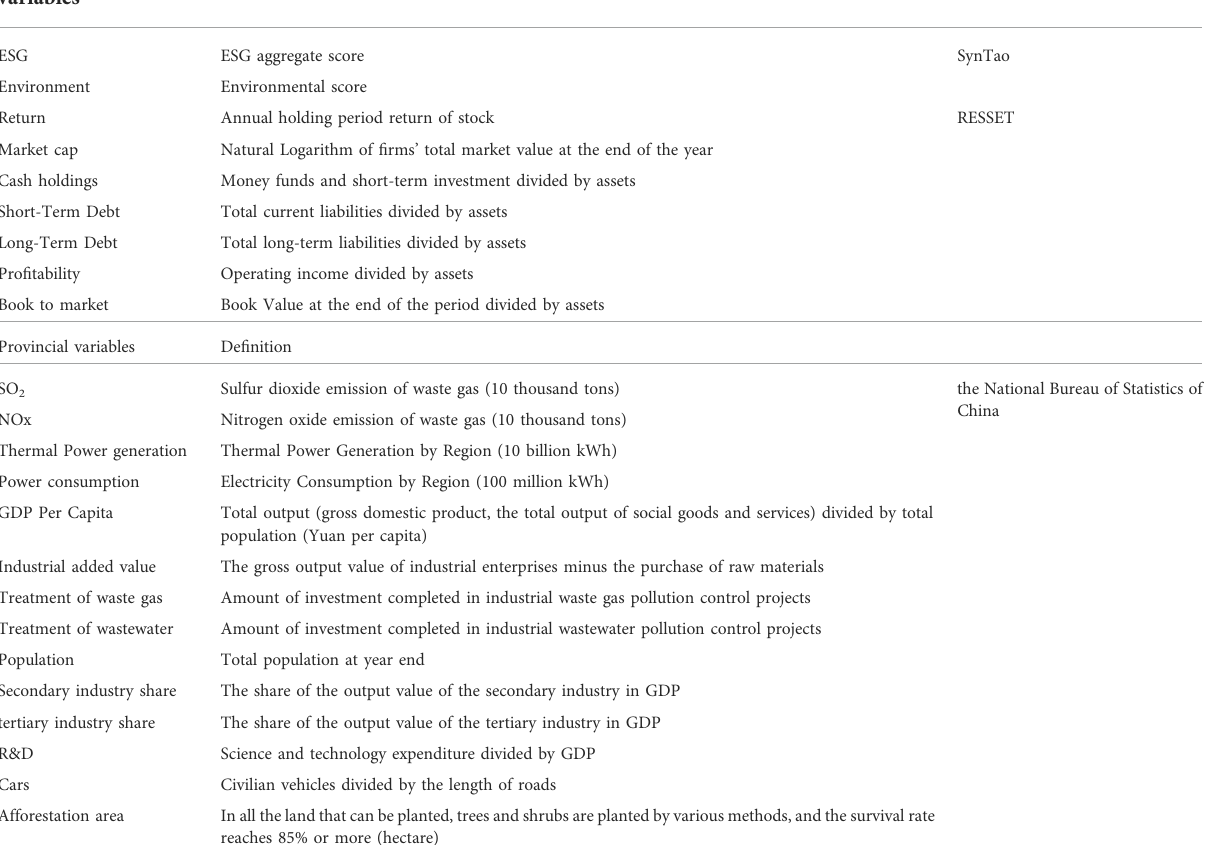
TABLE 1 De fi nition of